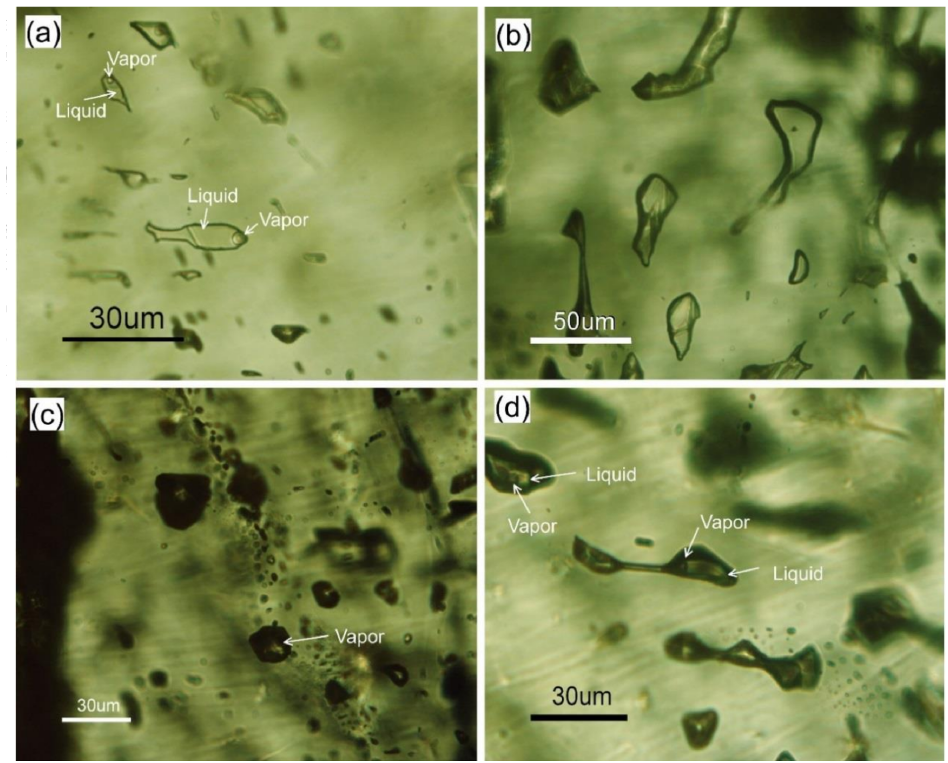
Figure 18. Microphotographs of the fluid inclusions in sphalerite from the Shah-Ali-Beiglou deposit (at room temperature in plane-polarized light). ( a ) Primary liquid-rich inclusions; ( b ) Liquid inclusions; ( c ) vapor inclusions in sphalerite; ( d ) Evidence of the necking down in fluid inclusions. Microthermometric measurements on two-phase liquid-rich fluid inclusions indicate that the mineralization taken place by dilute to high saline hydrothermal fluids with the salinity and temperature range of 0.35 wt % to 21.4 wt % NaCl equiv. and 123 to 320 ◦ C,